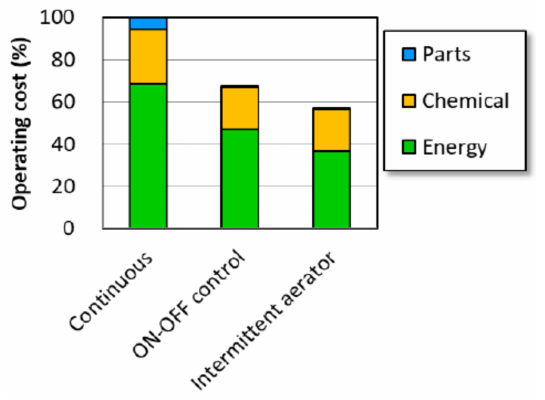
Figure 6. Operating cost comparison between continuous and intermittent